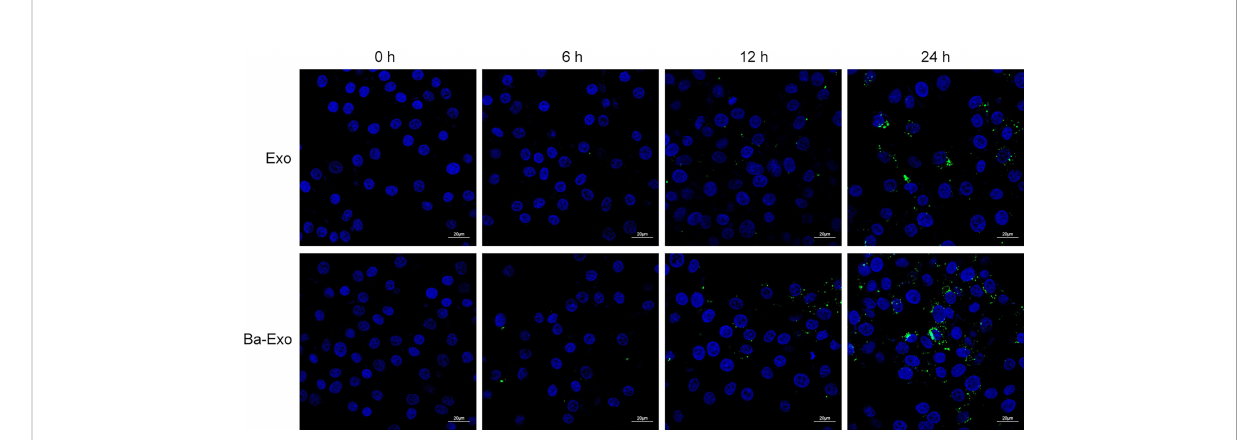
FIGURE 2 Time-course analysis of Exo and Ba-Exo uptake by M j (3D4/21). Representative images of Exo and Ba-Exo uptake by 3D4/21 after PKH67 green fl uorescent dye